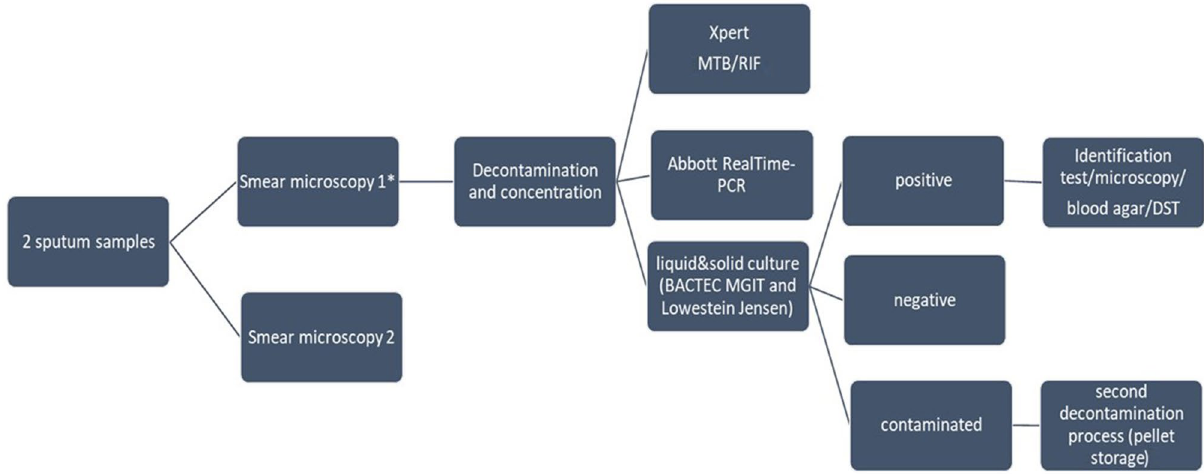
Figure 1. Laboratory flowchart. (*) The best quality sample was used to perform molecular